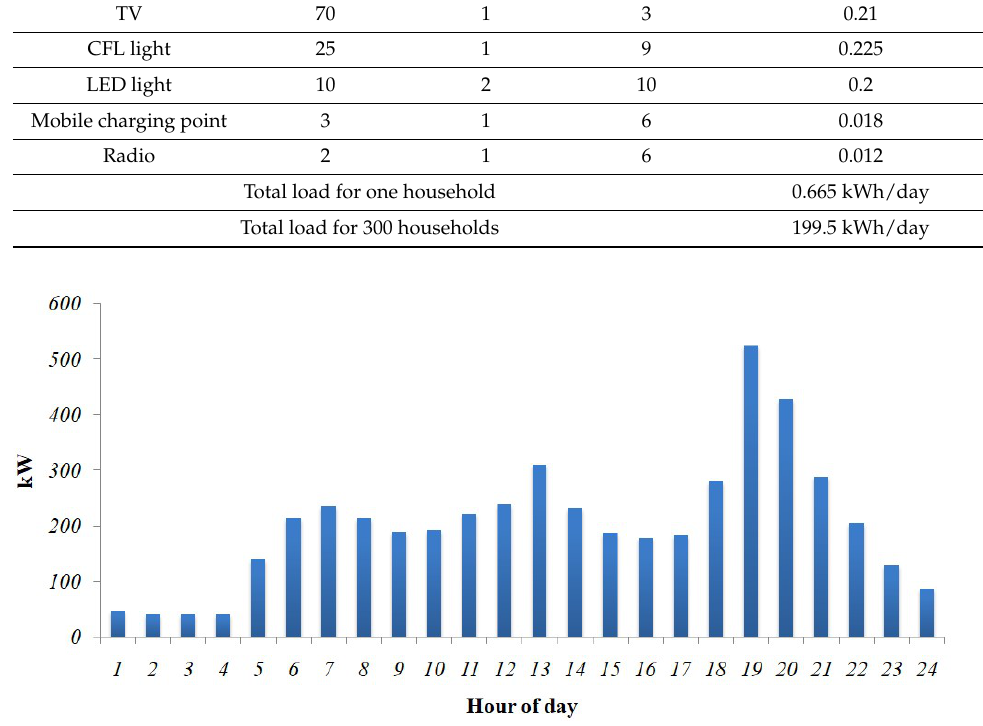
Figure 5. Daily residential load profile of the village.